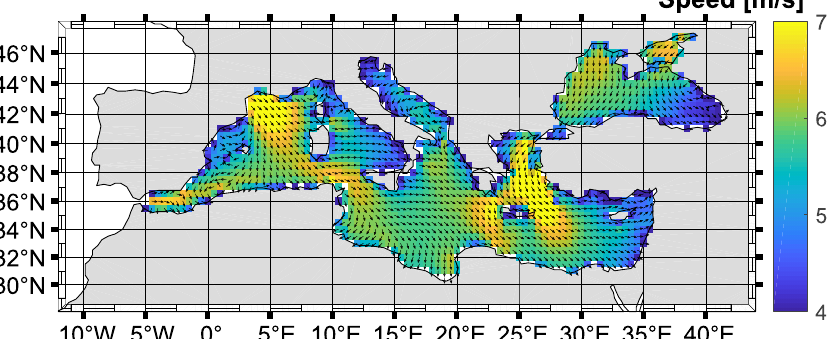
Figure 1. Mediterranean Sea. The figure shows the average wind over the Mediterranean Sea, with the vector indicating the direction and the color indicating the intensity.